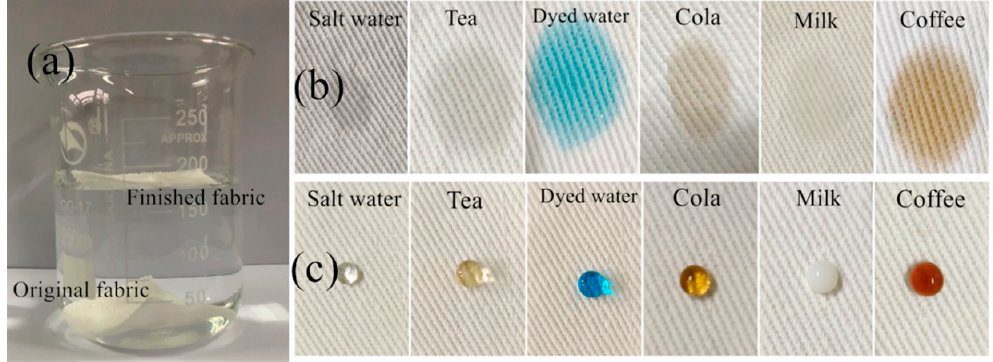
Figure 10. ( a ) Phenomenon of original cotton and modified cotton fabric immersed in water, ( b ) the state of different droplets on the original cotton fabric, and the state of the droplets on the modified cotton fabric ( c ).